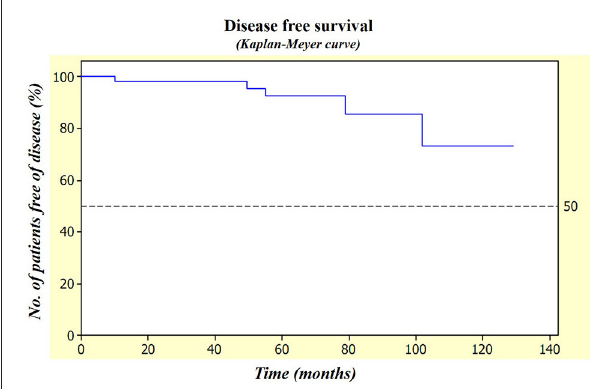
FIGURE 1 | Patients in this study revealed a high disease-free survival rate measured by the Kaplan–Meier curve reaching almost 90% after 5 years of